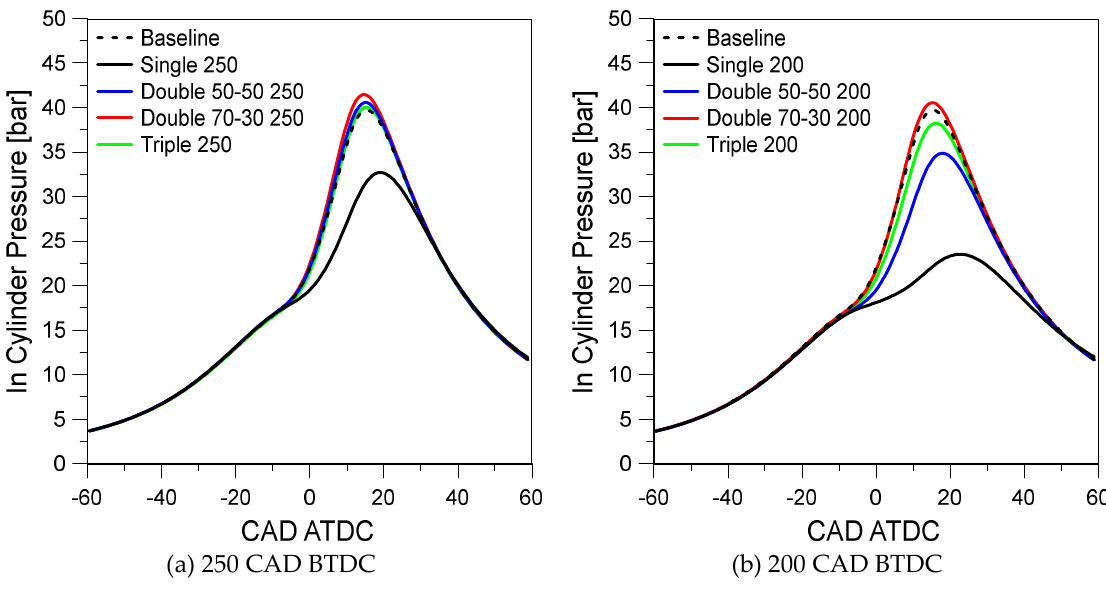
F igure 5. In-cylinder pressure for different split injection strategies at fixed SA (15 CAD BTDC) and